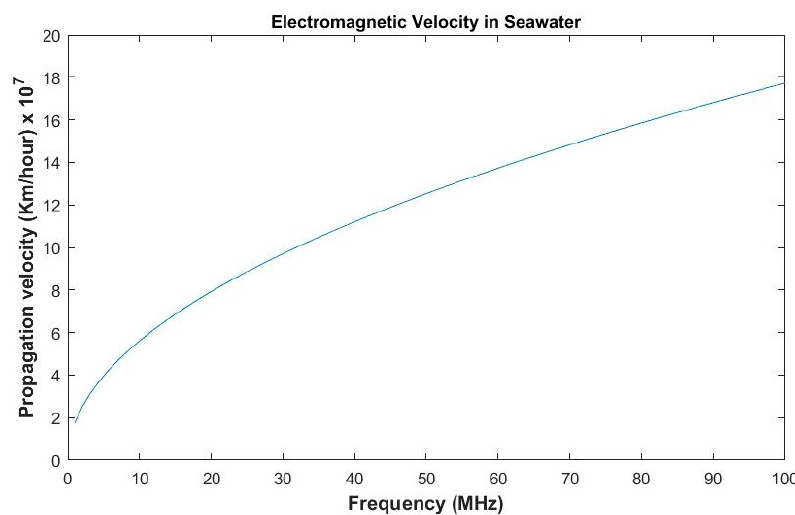
Figure 8. Electromagnetic wave velocity in seawater.